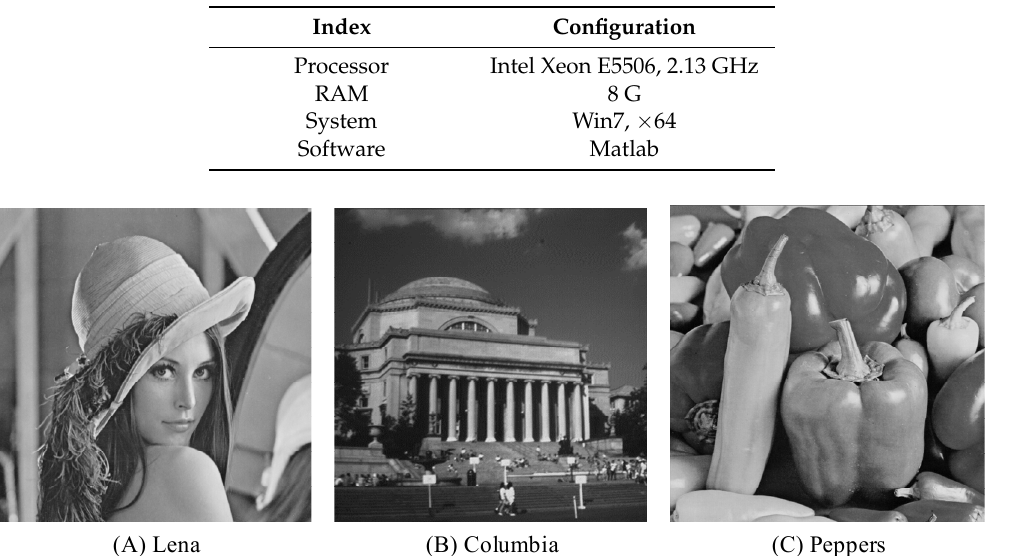
Table 1. Experiment configurations. RAM: random-access memory.